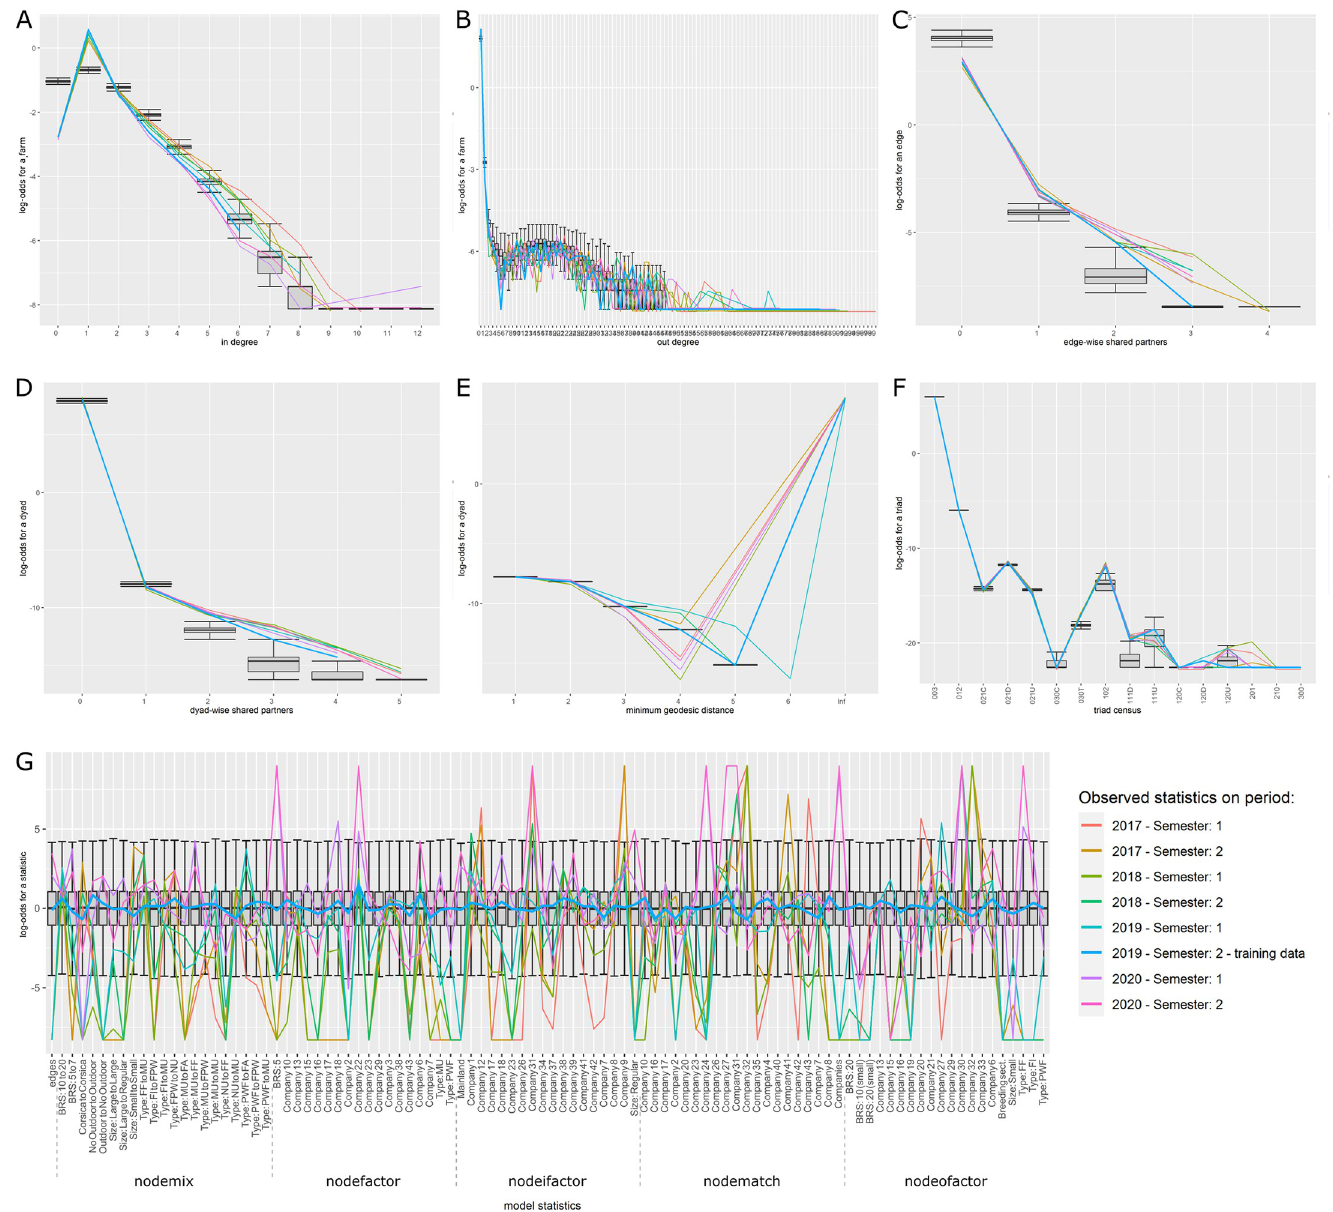
Fig 5. Goodness of fit of the sows model. Goodness of fit of the model adjusted for the transport of sows. Metrics of 4000 simulated networks (boxplot) are compared to metrics of observed semestrial network. Data of the second semester of 2019 were used for model fit (thick blue line). Colors correspond to different semesters’ networks. Details of the network metrics: A: indegree distribution, B: outdegree distribution, C: edgewise shared partners distribution, D: dyadwise shared partners distribution, E: minimum geodesic distance distribution, F: triads census, G: performance of the final model on in-model statistics.